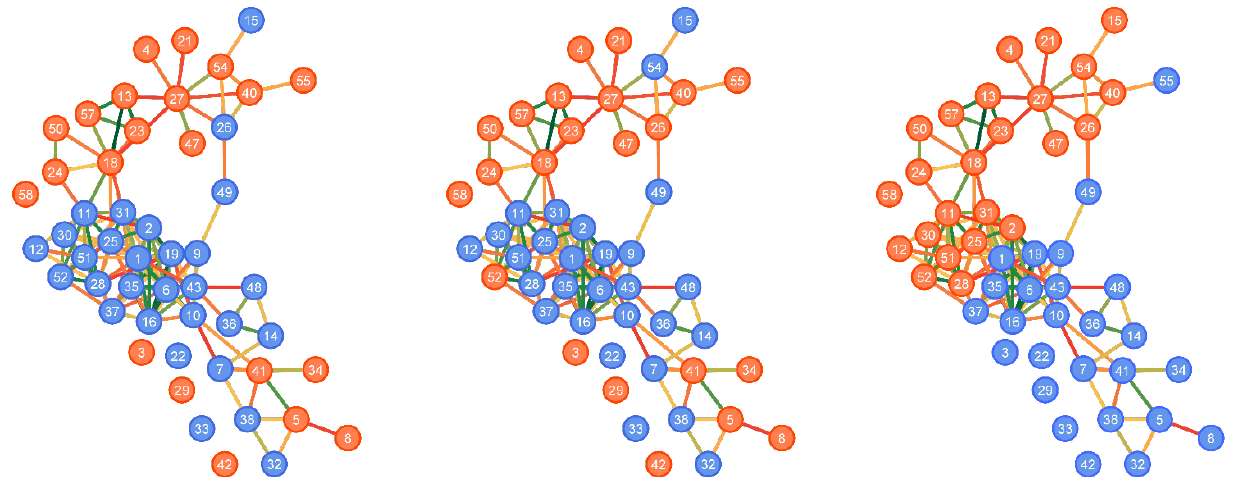
Figure 9. Clusters resulting from the three different approaches: k -means ( left ), clustering of the marginals ( center ) and clustering of the multi-dimensional histograms ( right ).